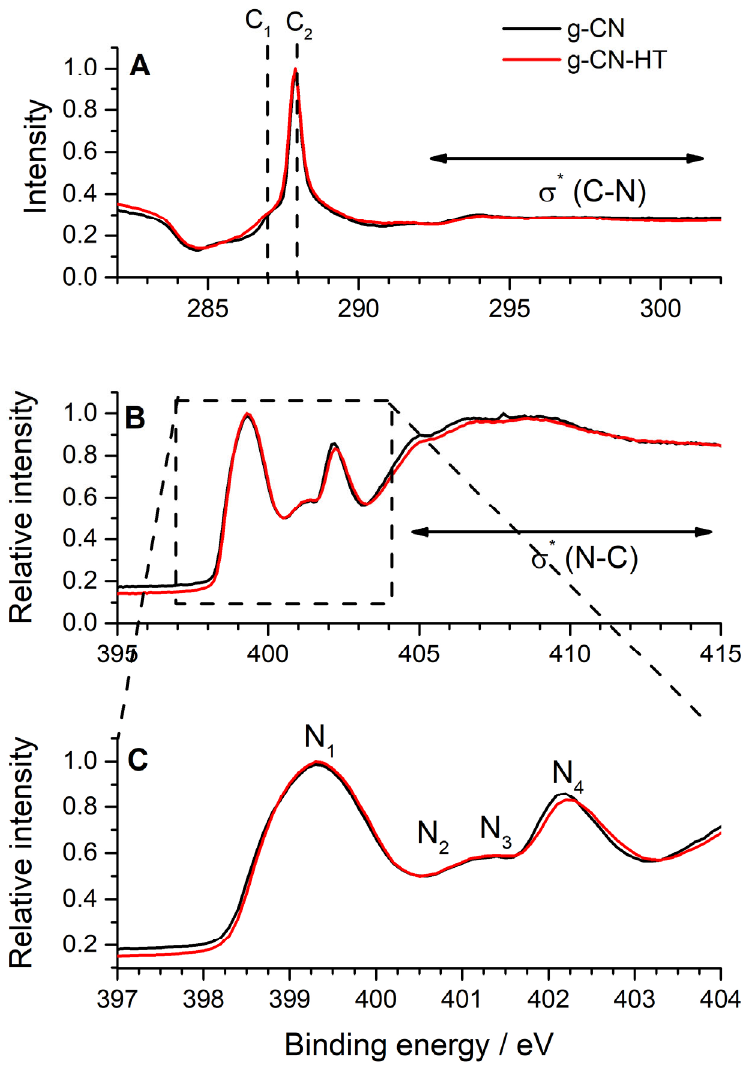
Figure 2. NEXAFS: C 1s K-edge; σ * at binding energies >292 eV refers to C1s → σ * transitions ( A ), N 1s K-edge; σ * at binding energies larger than 405 eV refers to N1s → σ * transitions ( B ) and detailed structure of the N 1s K-edge from 397 to 404 eV ( C ).